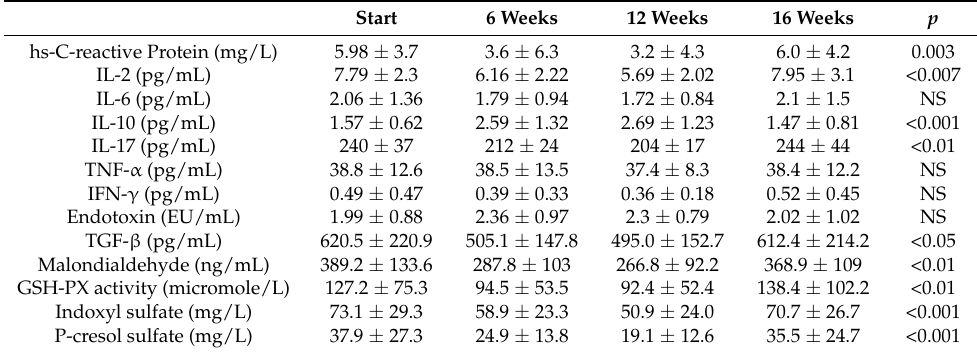
Table 3. Markers of inflammation, oxidative stress and gut-derived toxins at study baseline, 6 and 12 weeks after the intervention and 4 weeks after stopping SP